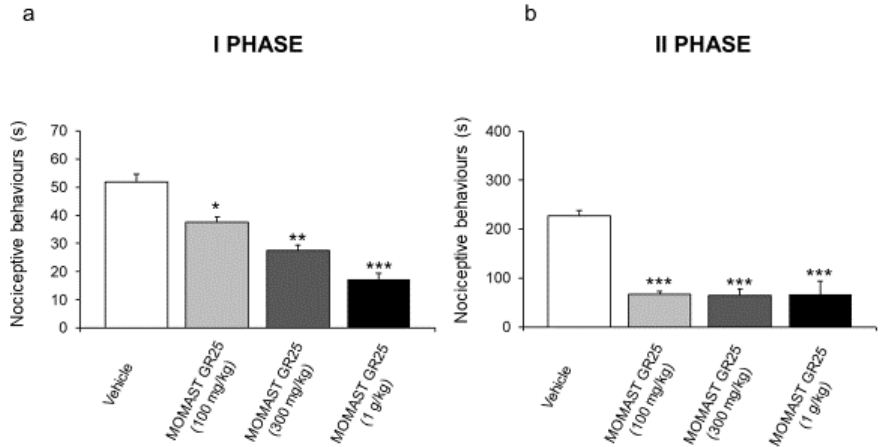
Figure 2. Effect of MOMAST ® GR25 (100, 300 mg/kg, and 1 g/kg) oral administration on the acute nociceptive response in the formalin test (n = 6 for each group of treatment). The nociceptive behav- ior time (seconds) of licking, shaking, and biting was measured during the period of 0 – 5 min (first phase) ( a ) and 20 – 60 min (second phase) ( b ). Data were reported as means ± SEM. One-way analysis of variance (ANOVA), p < 0.01; post-hoc test, * p < 0.05, ** p < 0.01, and *** p < 0.005 vs. vehicle-treated animals.